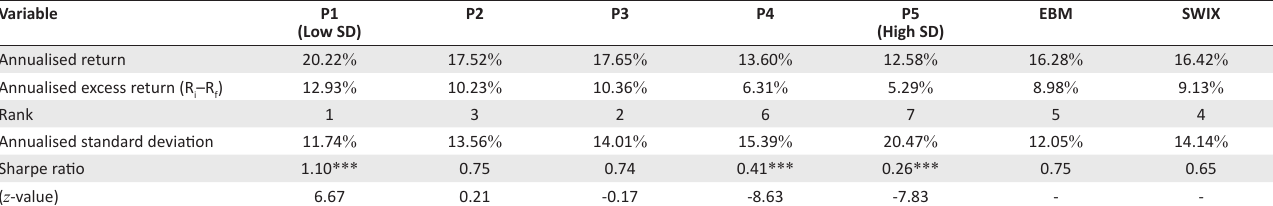
TABLE 3: Quintile portfolios based on historical standard deviation. Variable